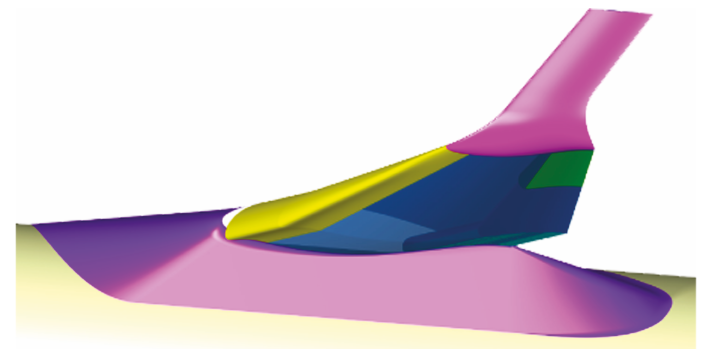
Figure 22: CAD surface of the morphing droop